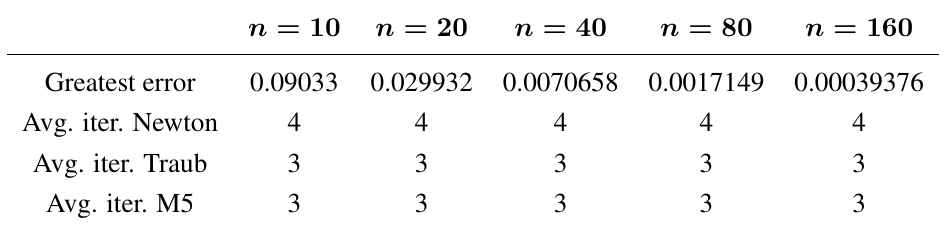
Figure 1. Solution ( a – c ) and error progression curve ( d – f ) for different times and ε values, = 1 . with n = m = 40 and t max Table 1. Comparison of the GE (greatest error) and methods iterations for different amount of space subintervals.